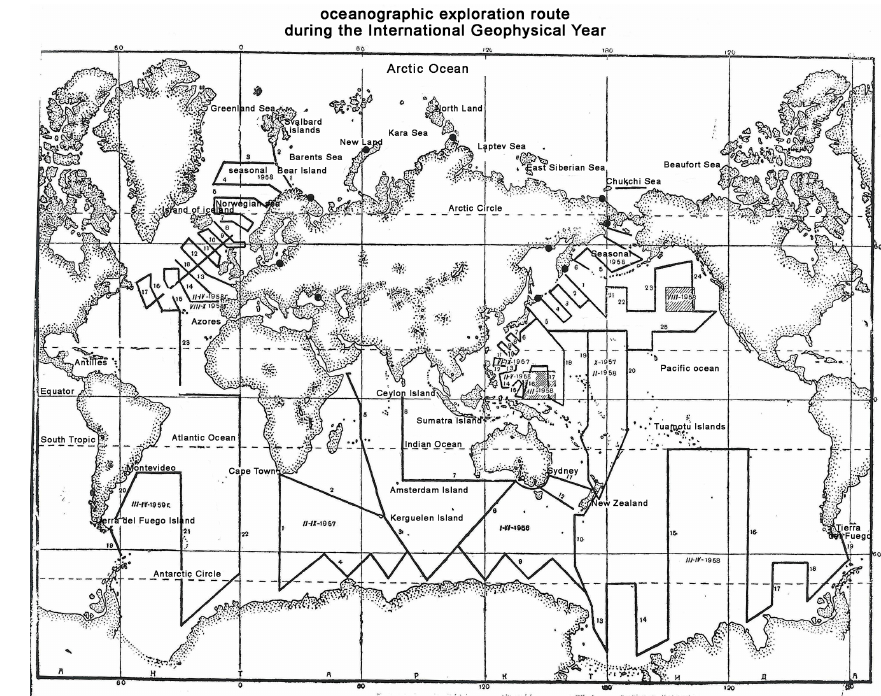
Figure 9. Oceanographic exploration route during the International Geophysical Year (Troitskaya, 1957).